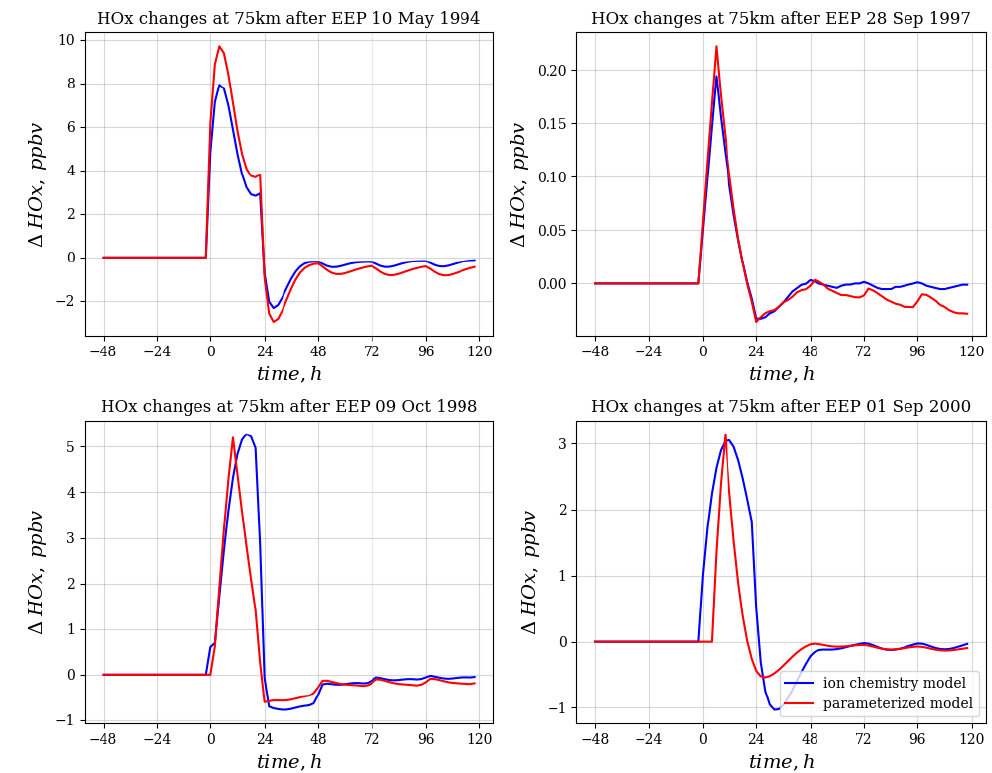
Figure 4. Simulation results of HO x change at 75 km. The 0 on the horizontal scale is midnight of the corresponding day.